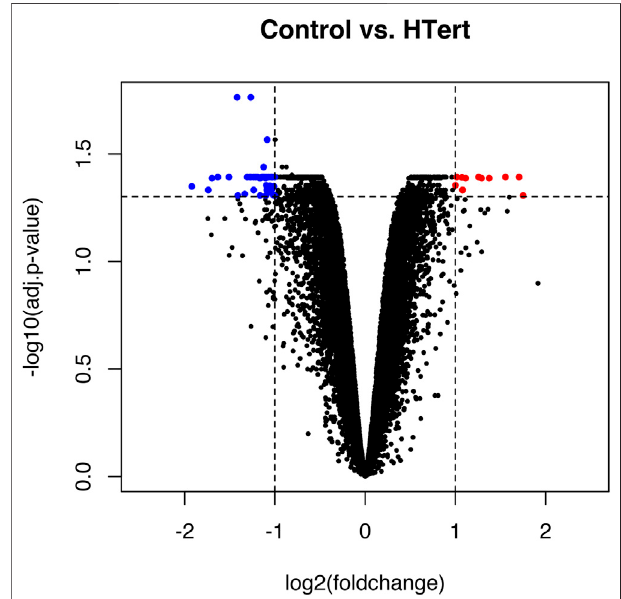
FIGURE 5 | Volcano plot representing the global pro fi le of gene expression of hPLF cells after the immortalization procedure. Blue dots represent downregulated genes and red dots represent upregulated genes. Data were expressed as log2FC > 1 or < − 1 and analyzed by Student ’ s t -test, adopting adj. p < 0.05 ( n (cid:2) 3/each